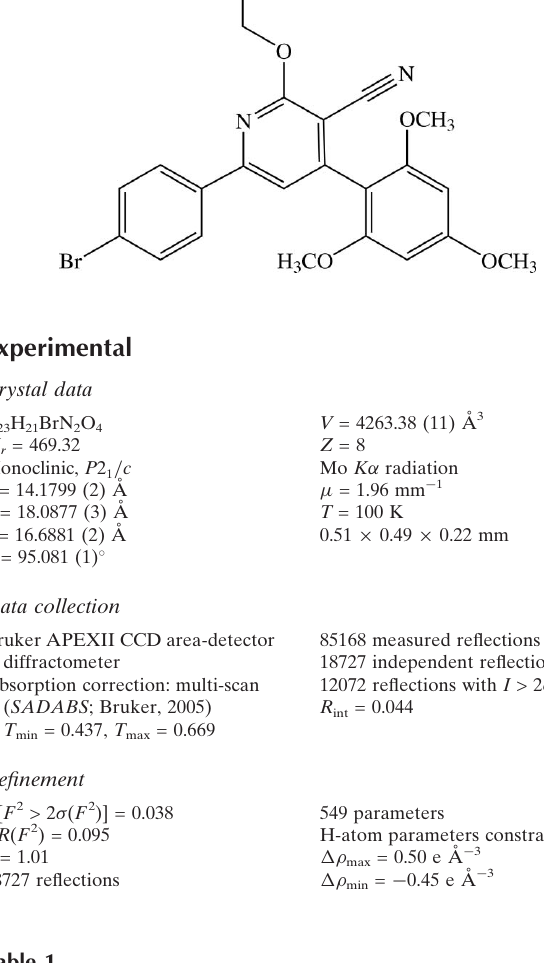
Hydrogen-bond geometry (A˚ , (cid:2)